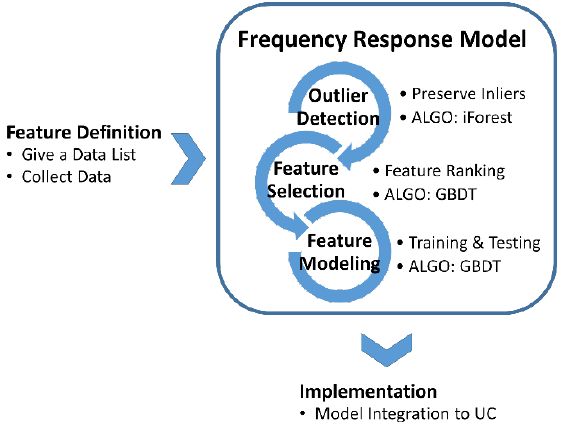
Figure 1. Procedure of constructing a CPS1-compliance model (ALGO: algorithm).